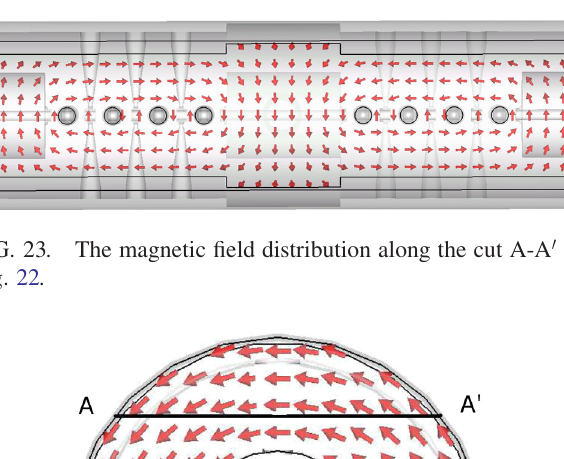
FIG. 22. The electric field pattern along the symmetry plane for the coupled CH-DTL.